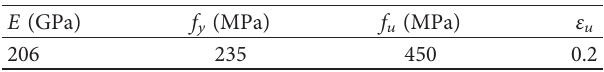
Figure 9: Diagram of the BEM-K (length unit: mm). Table 4: Material properties of the BEM-K and SEM.